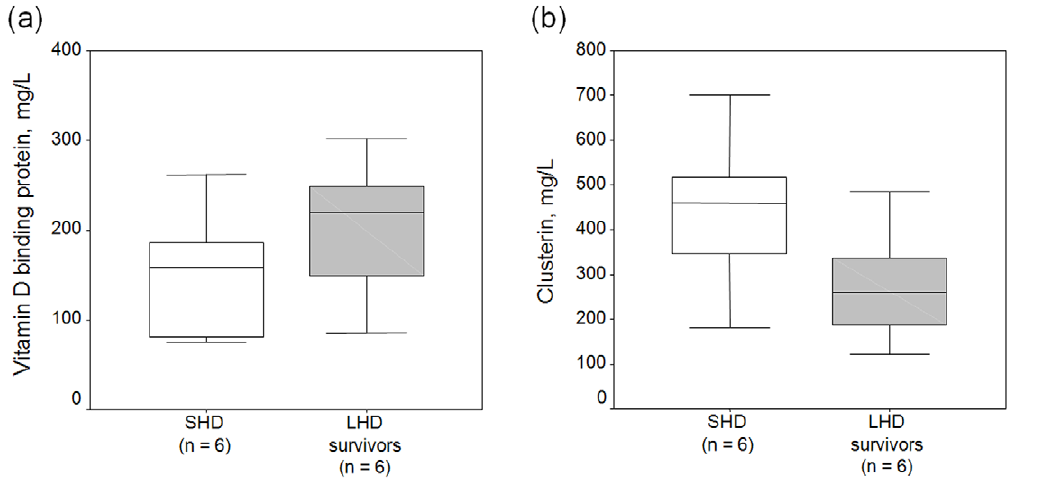
Figure 3. Box plots of plasma vitamin D binding protein and clusterin levels in HD patients. ELISA validation of vitamin D binding protein and clusterin concentration for patients’ plasma originally analyzed by 2-DE. Long-term HD survivors have (a) higher vitamin D binding protein (204.5 6 63.9 mg/L vs. 149.0 6 71.6 mg/L, p=0.036) and (b) lower clusterin (282.3 6 105.8 mg/L vs. 438.5 6 174.2 mg/L, p=0.011) than the short-term HD patients, which are concordant with 2-DE expression pattern.